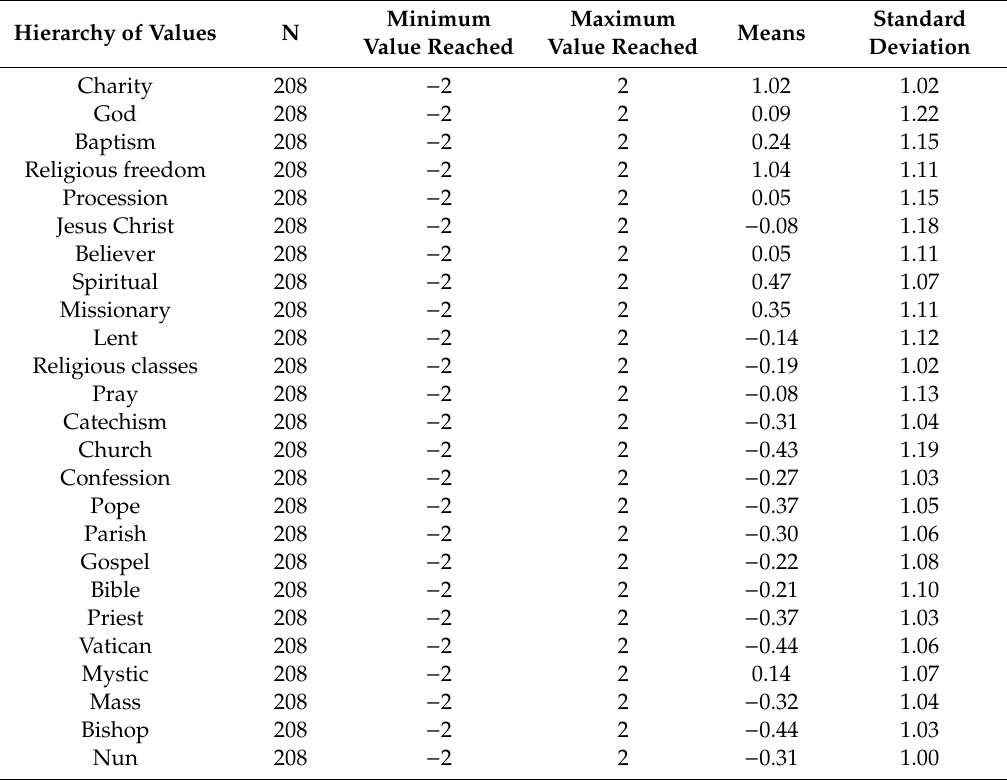
Table6. Descriptiveresultsofthetermsmakingupthereligiousvaluescategory(secularschoolstudents. Hierarchy of